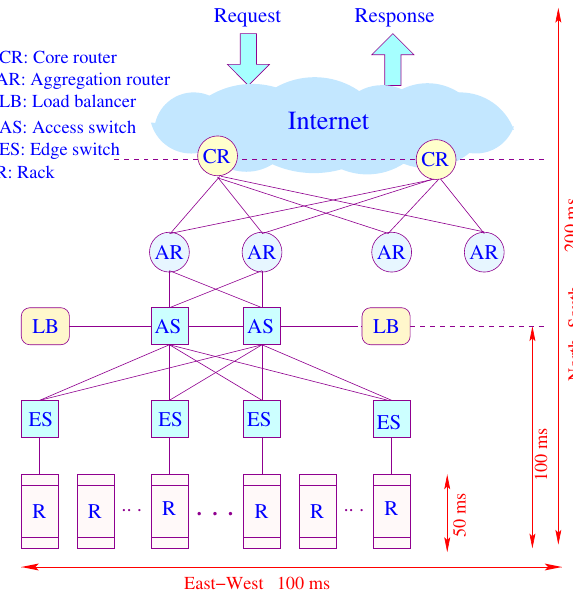
Figure 7. An illustration of latency components.